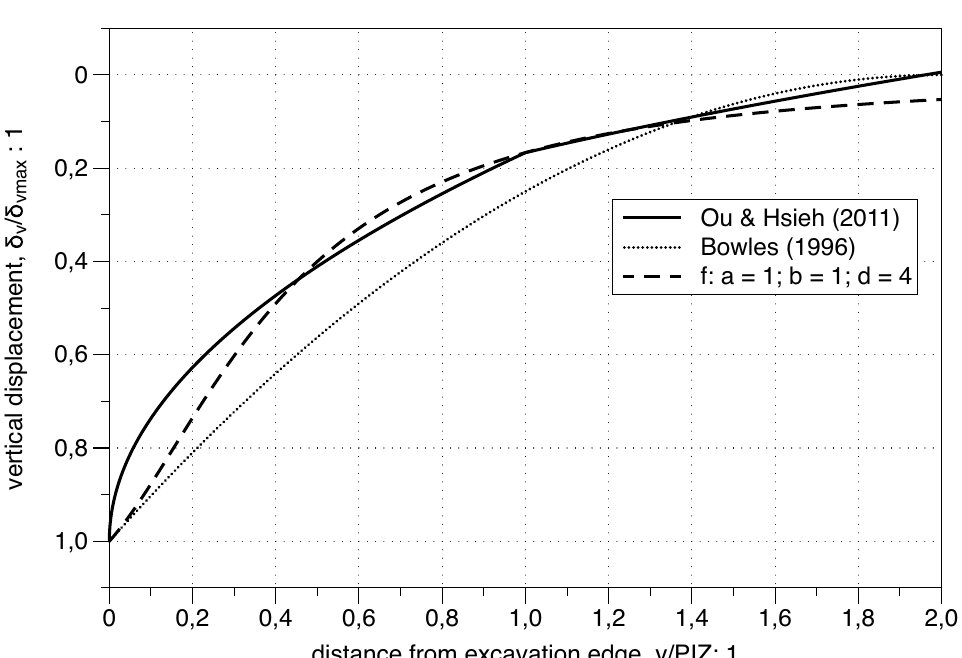
Figure 3. Spandrel settlement